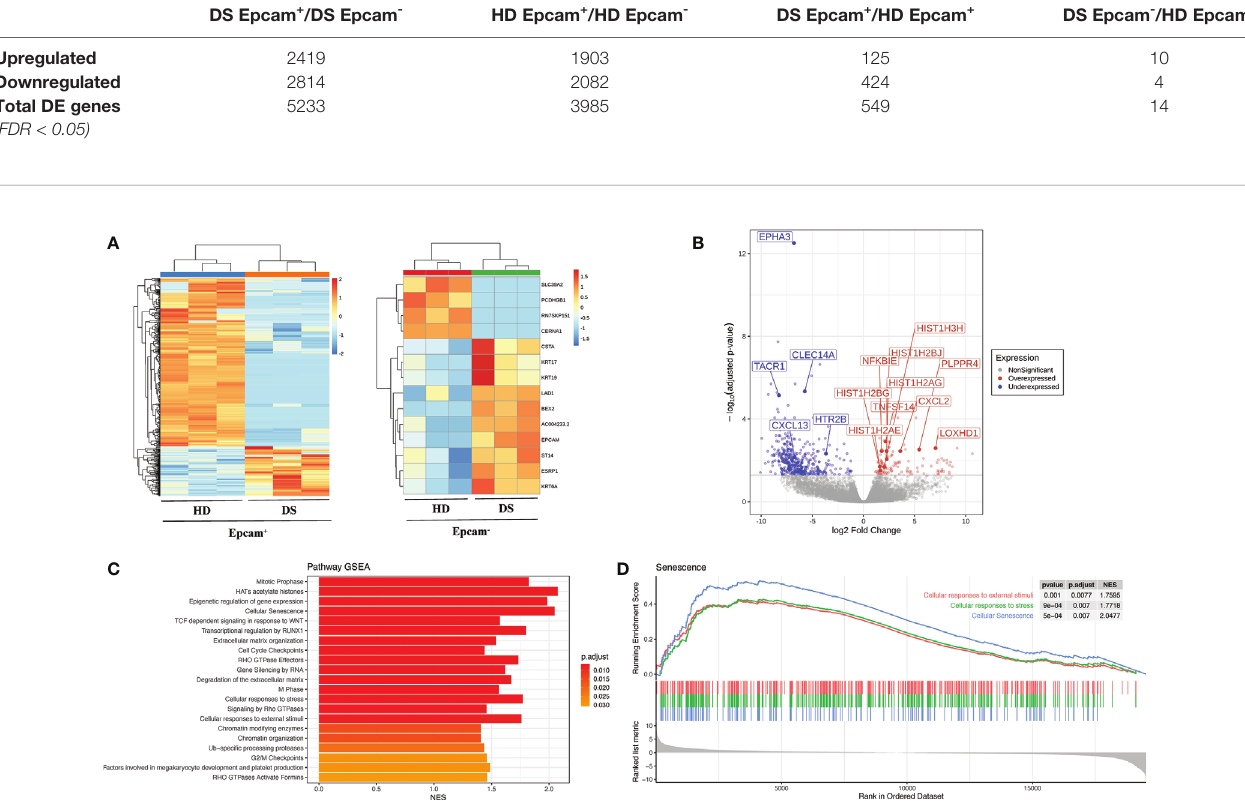
Log2-fold change and FDR adjusted p-values (padj) are reported, obtained from the comparison of Epcam + and Epcam - cell subsets within each subject ’ s group. Positive log2-fold change values indicate upregulation of that speci fi c gene in Epcam + cells.